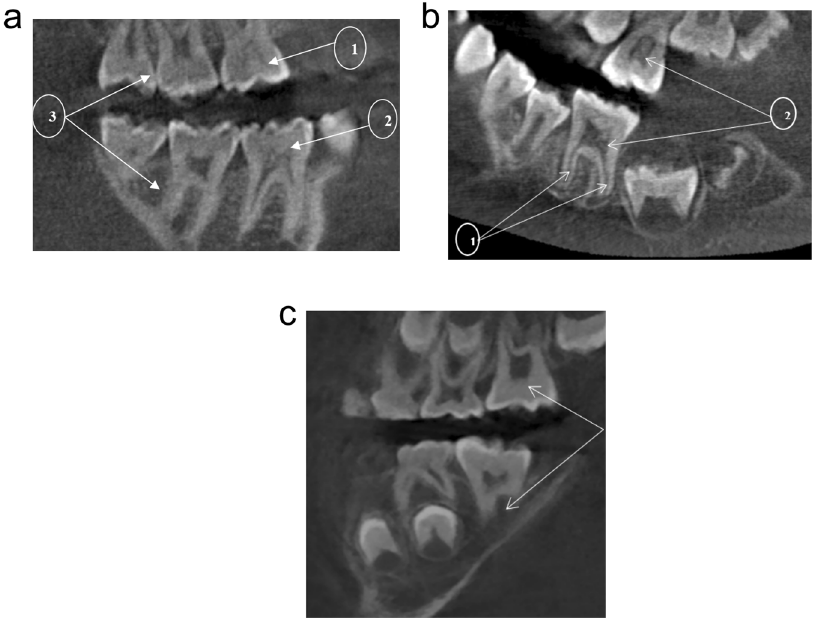
Fig. 2 Radiographic images of taurodontism in molars in patients with OI, Torg-Winchester syndrome and Pyle disease. a Cropped CBCT image of an individual with phenotypic OI III (OI XI genotype). Intrapulpal calci fi cation (1) and an unusual occlusal anatomy (2) in teeth 17 and 29 are indicative of hypotaurodontism (3); b an individual with Torg-Winchester syndrome. The mandibular molar (L) has 2/3rd of root development completed (1). Large coronal pulp chambers are suggestive of hypotaurodontism and contain several intrapulpal calci fi cations (2); c An individual with Pyle disease and mesotaurodontism of the fi rst permanent molars (arrows).